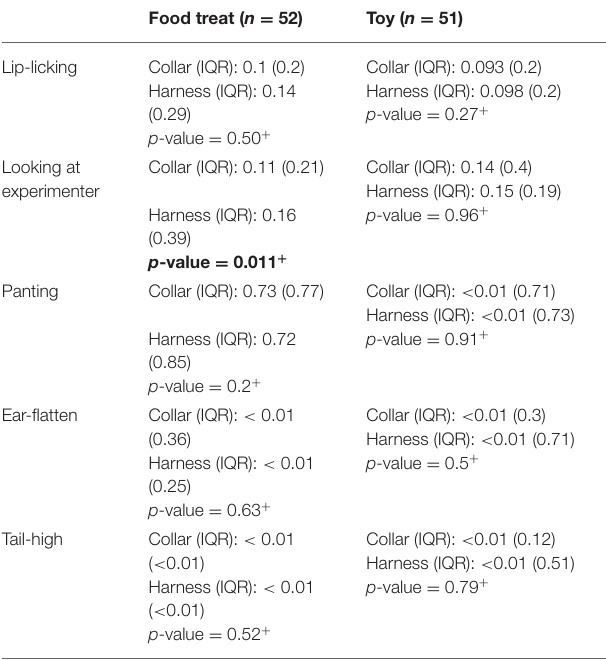
TABLE 4 | Bivariate analysis (Wilcoxon signed-rank test) of behaviours expressed in neck collar and chest harness